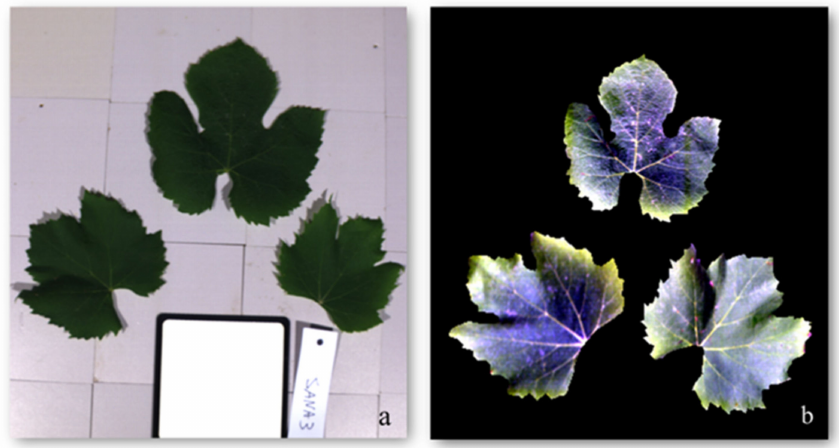
Figure 4. Panel ( a ) shows a sample of an RGB photo of three leaves made with the Specim IQ camera. Panel ( b ) shows a sample of the hyperspectral image made with Specim IQ of the same leaves. We analyzed the images using ENVI software (L3Harris Geospatial Solutions Inc., Broomfield, CO, USA). First, we extracted the leaves as the region of interest (ROI) and excluded background pixels. Then, we calculated the mean reflectance of the leaves, by averaging all pixel values included in the ROI. Noisy bands at the tails from 397 nm to 423 nm and bands from 954 nm to 1003 nm were eliminated, minimizing the background noise [38].